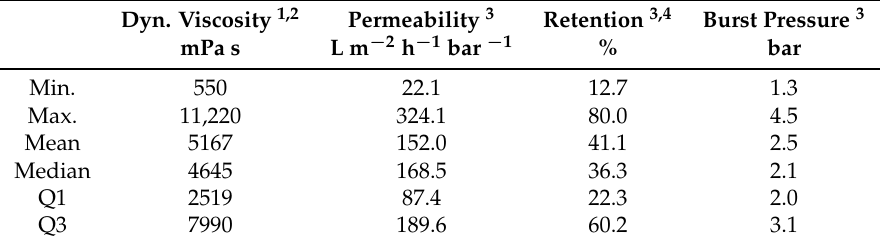
Table 2. Basic statistics of investigated outcome